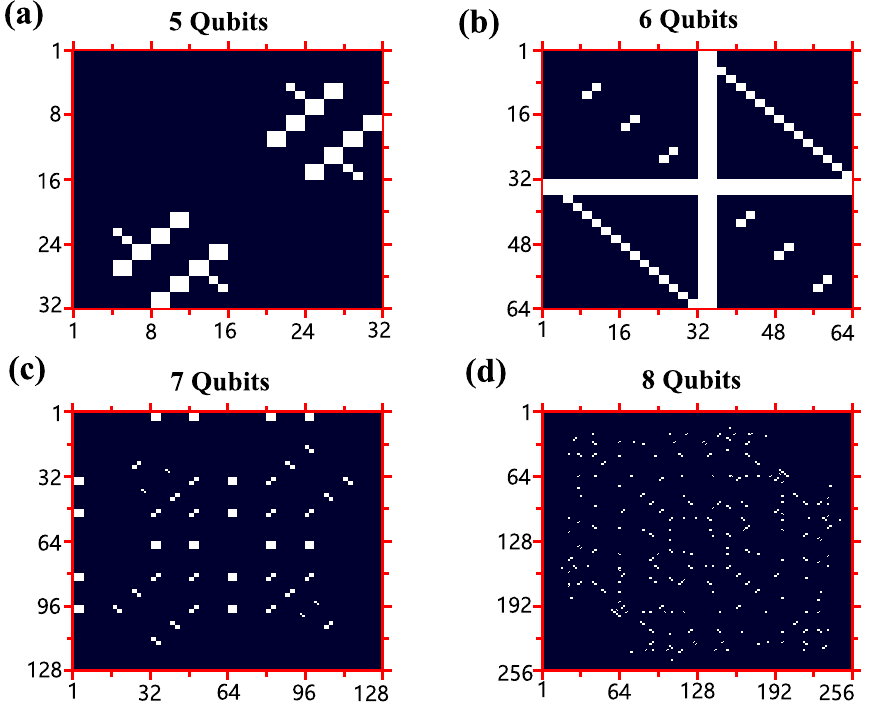
Figure 6. The locations of special entries are marked in the density matrices. ( a ) Example of 5 qubits. ( b ) Example of 6 qubits. ( c ) Example of 7 qubits. ( d ) Example of 8